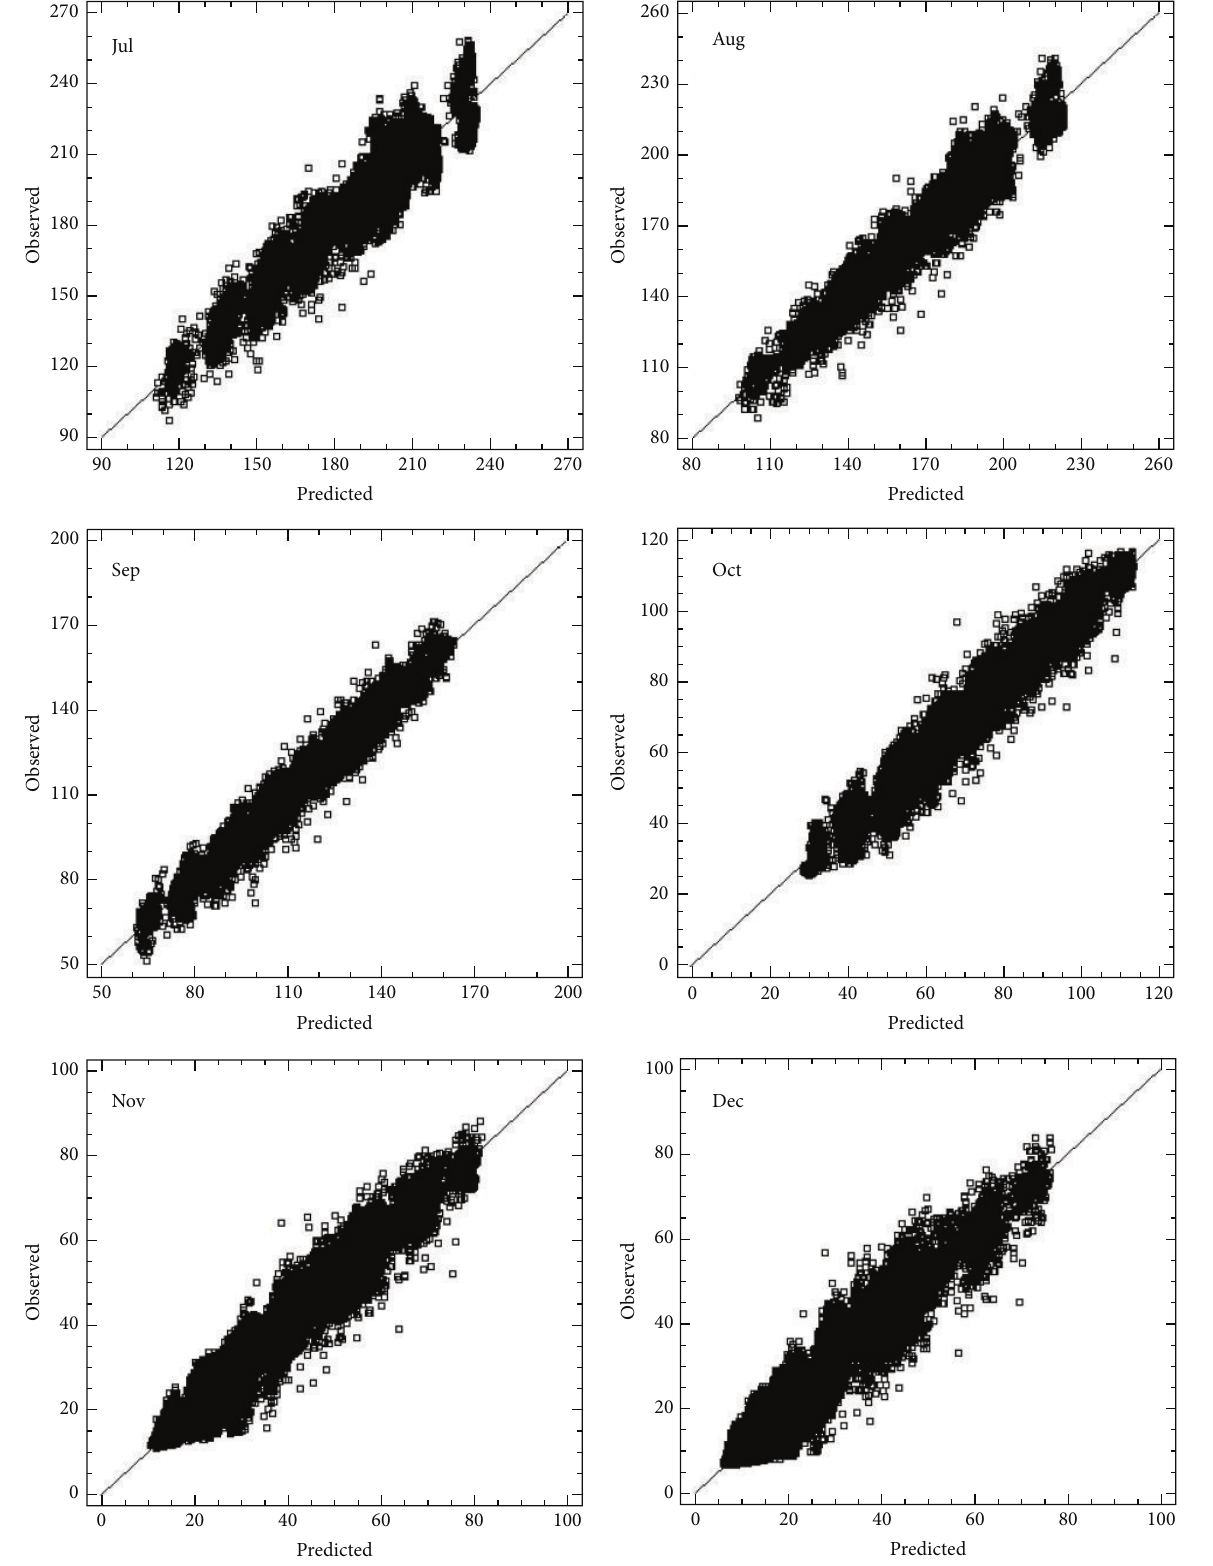
Figure 5: Observed versus predicted values of the BoxCox transformed mean monthly ET 𝑜 using the models of Table